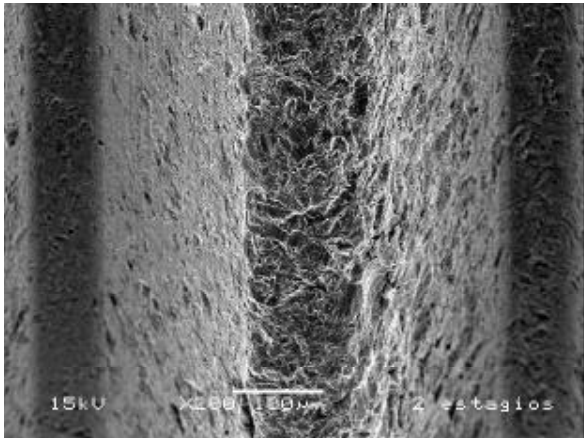
FIGURA 6- Superfície revestida por RBM. Observar